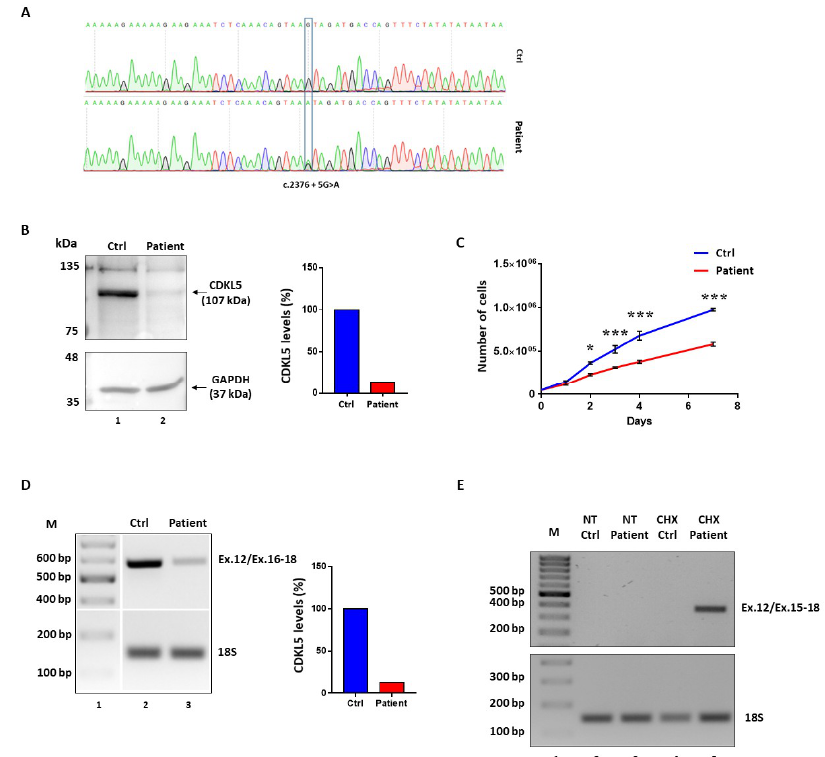
Figure 2. Ex vivo studies indicate that the c.2376+5G>A variant is associated with exon 16 skipping and nonsense-mediated mRNA decay. ( A ) Electropherograms showing the sequence of CDKL5 exon 16 in a control (Ctrl) or a heterozygous patient harboring the c.2376+5G>A mutation obtained from the genomic DNA of the corresponding lymphoblastoid cell lines. The position of the mutation is indicated by a blue rectangle. ( B ) Western blotting analysis of CDKL5 expression in the immortalized lymphocytes from the control (lane 1) or the CDKL5 -deficiency disorder (CDD) patient (lane 2). Histograms report the amount of CDKL5 protein isoform calculated by densitometric analysis of bands and normalized to GAPDH. ( C ) Growth rate curve of immortalized lymphocytes from the control donor or the CDKL5 patient. Asterisks indicate a significant difference between the number of control and patient’s cells at the selected time points. * p < 0.05; *** p < 0.001 by two-way repeated measure ANOVA, followed by Sidak’s multiple comparison test. ( D ) Reverse transcriptase (RT)-PCR evaluating the splicing pattern of CDKL5 exon 16 in the immortalized lymphocytes using the forward primer located in exon 12 and the reverse primer binding the exon 16–18 junction. Levels of 18S rRNA were used as internal standard. Histograms report the relative amount of correctly spliced CDKL5 mRNA in patient’s cells with respect to control, arbitrarily set at 100%. ( E ) Evaluation of CDKL5 exon 16 skipping transcripts after 4 hours of cycloheximide treatment (CHX; 300 mg/mL) by RT-PCR using the forward primer located in exon 12 and the reverse primer binding the exon 15–18 junction. Thus, 18S amplification was used as internal standard.